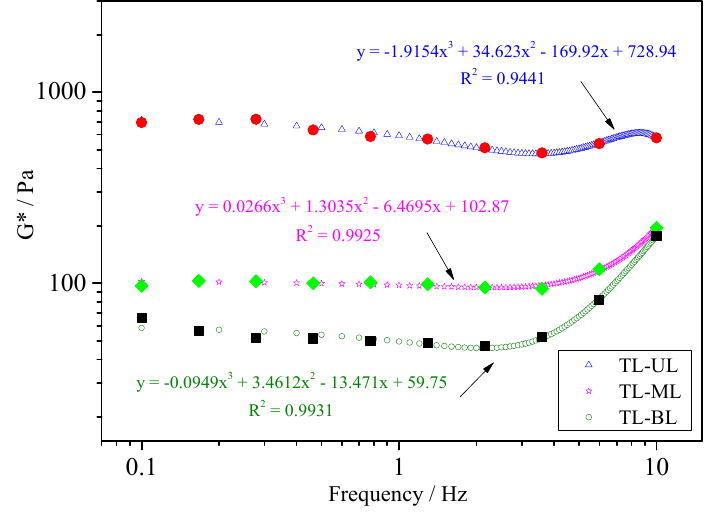
Figure 10. Complex shear modulus of bitumen from TL-UL, TL-ML, and TL-BL. 237